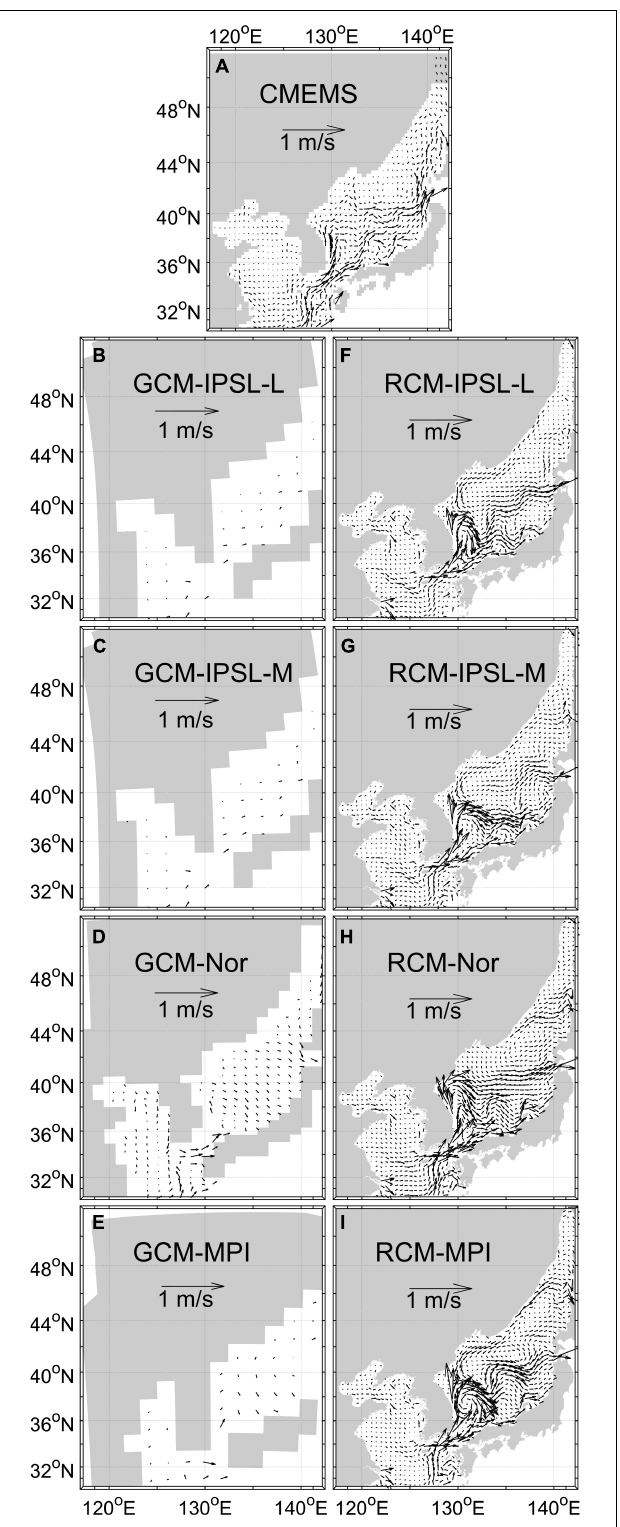
FIGURE 4 | Mean surface currents in the NWP marginal seas: (A) Satellite-derived geostrophic current from CMEMS, and mean surface currents of panels (B–E) GCMs and (F–I) RCMs, 1993–2005.